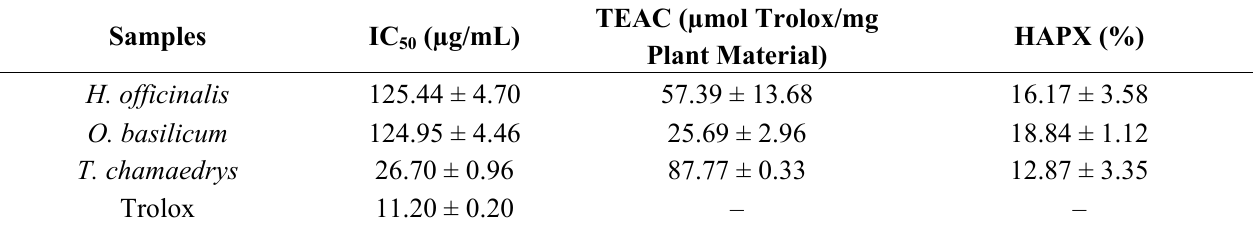
Table 3. Antioxidant capacity parameters obtained using several methods for studied